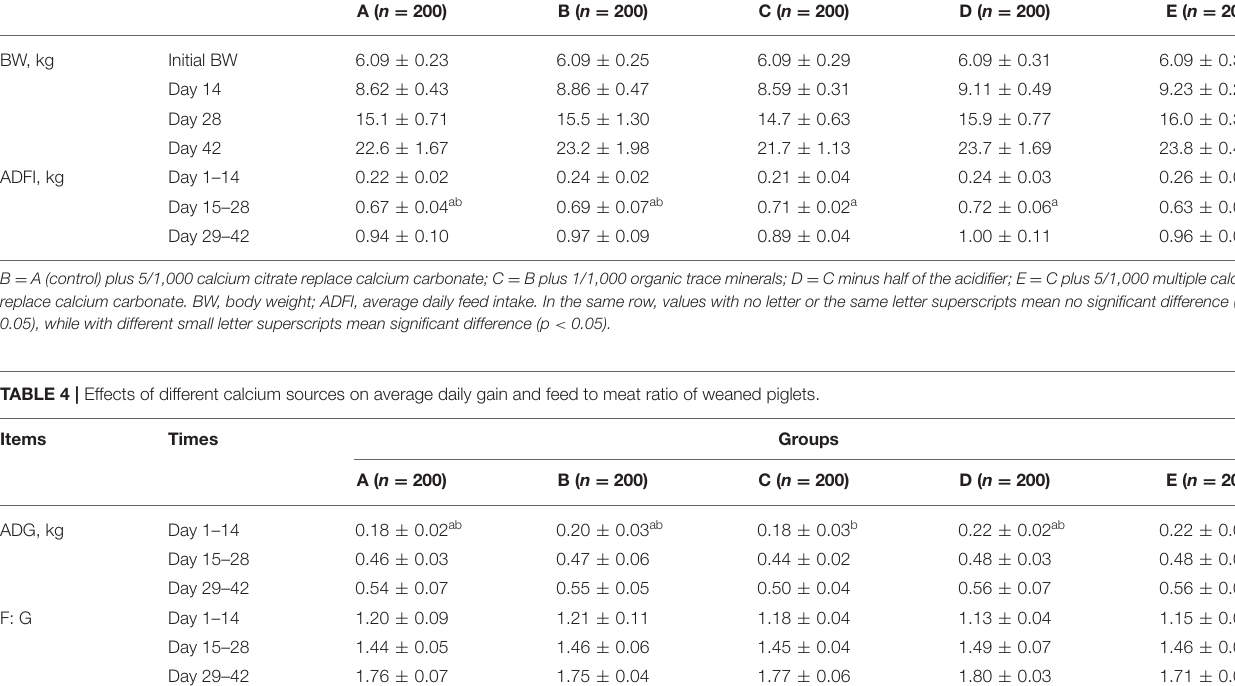
TABLE 3 | Effects of different calcium sources on body weight and average daily feed intake of weaned piglets. Items Times